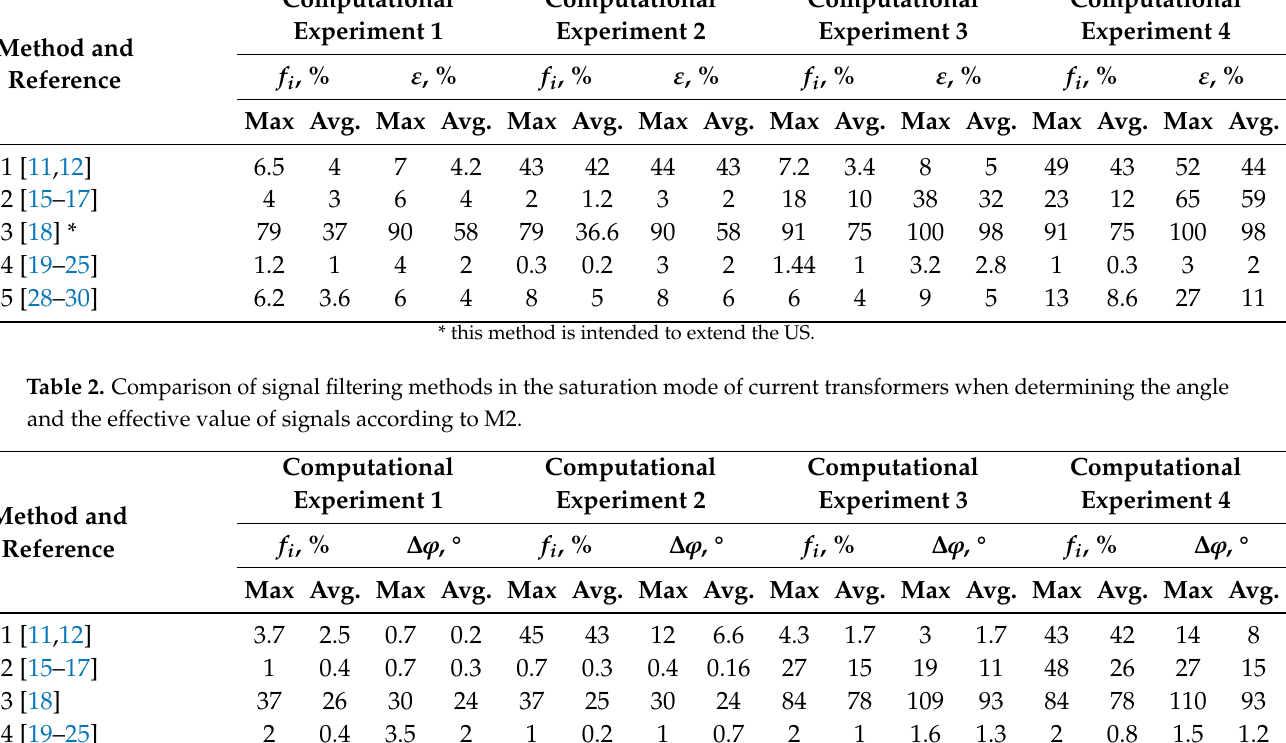
Table 1. Comparison of signal filtering methods in the saturation mode of current transformers when determining the effective value of signals according to M1.